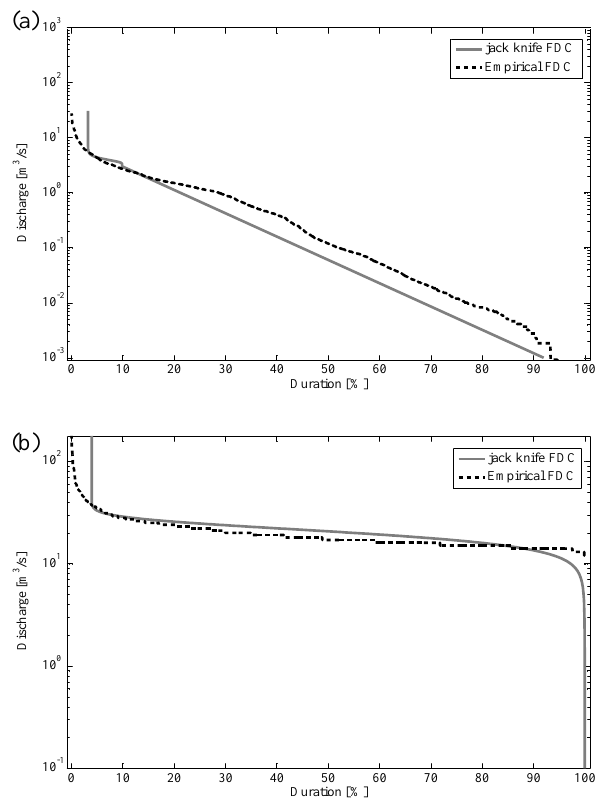
Fig. 12. Semi-logarithmic representation of empirical and jack- knife FDC for site n. 5 (intermittent regime) (a) and for site n. 1 (permanent regime) (b) .